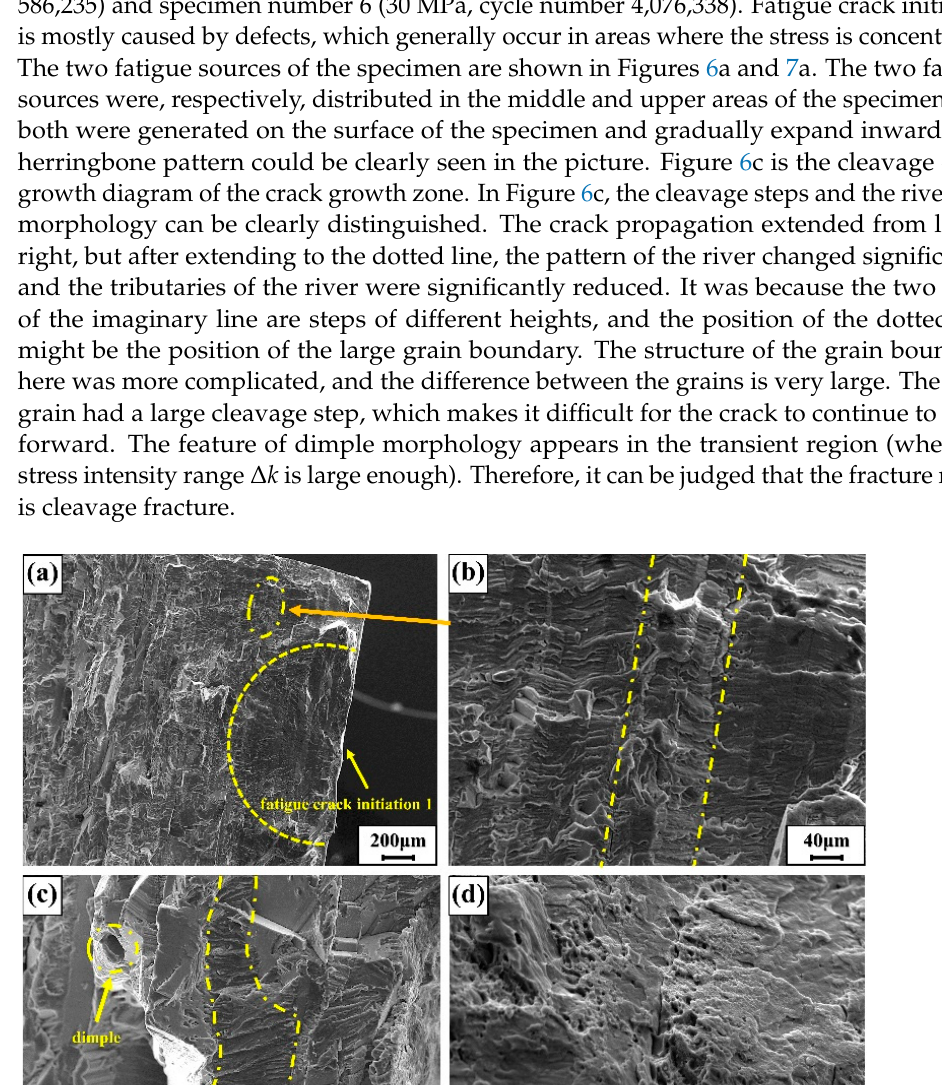
Figure 7. ( a ) Fatigue source zone 2; ( b ) partial high-magnification SEM image; ( c ) model images of cracks and fatigue bands; ( d ) SEM images of cracks at higher magnification. Figures 6b and 7b are both about fatigue strip morphology in the fatigue crack growth region. In Figure 6b, the dotted line was divided into three regions. The middle part bulged upward, and the three areas were obviously not on the same plane. Because those were also different than the fatigue band orientation and morphology of the three regions. The grains in this area are complex and diverse, causing the fatigue bands to be distributed on different planes, and the different grain orientations lead to changes in the normal direction of the fatigue bands and changes in the morphology of the fatigue bands.